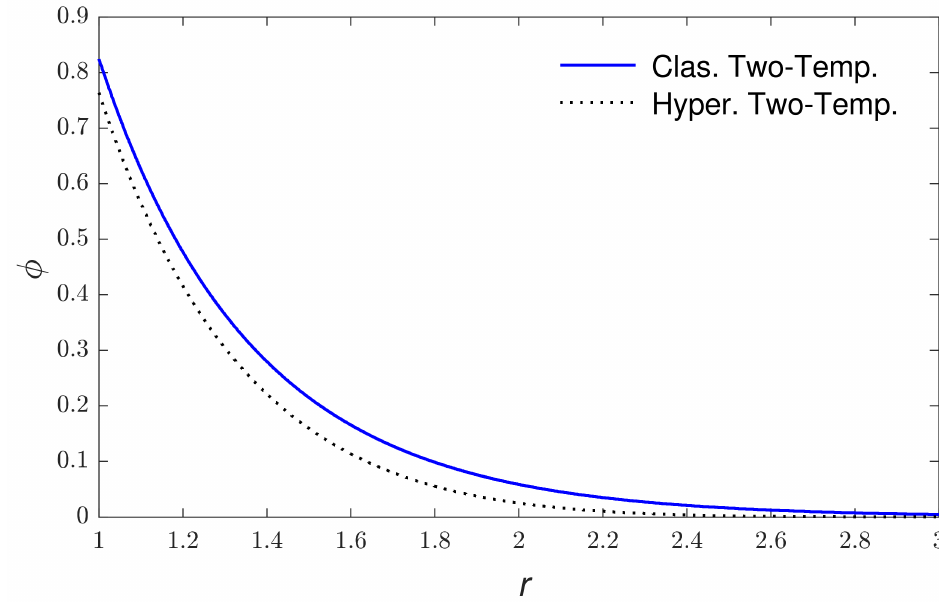
Figure 4. The conductive temperature variations versus the redial distance.